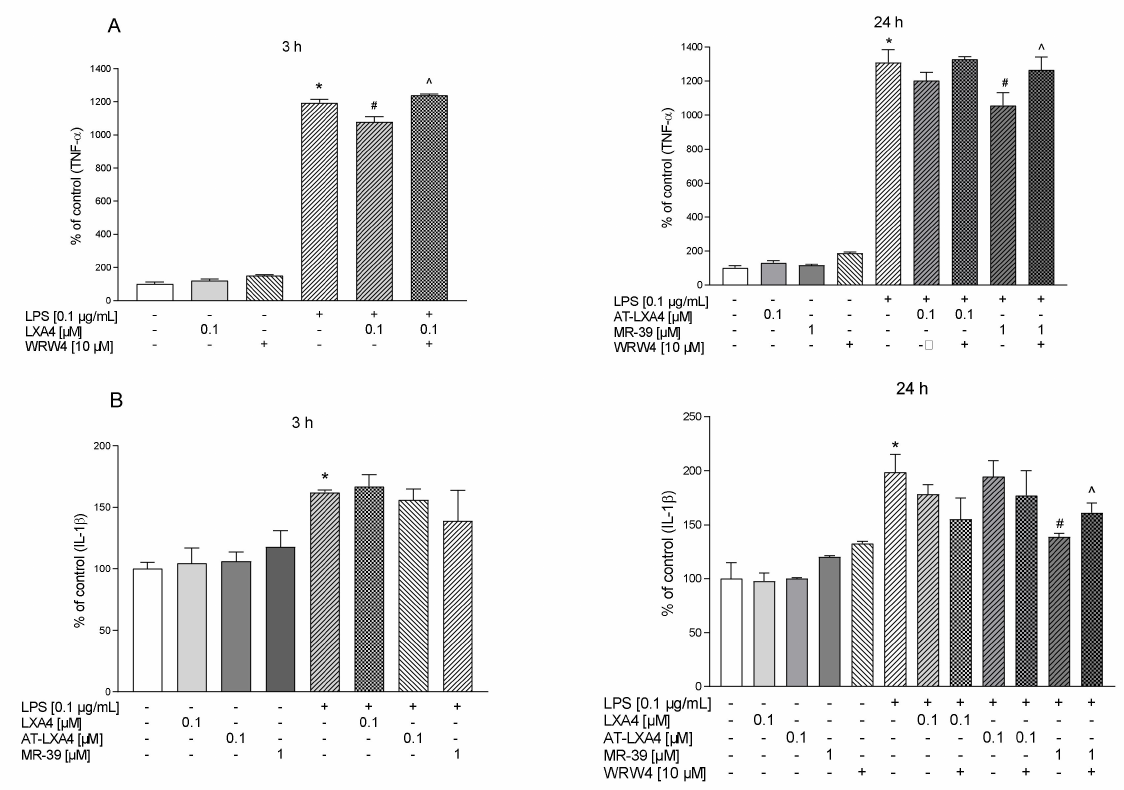
Figure 8. The impact of LXA4, AT-LXA4, and MR-39 on pro-inflammatory cytokines: TNF- α ( A ) and IL-1 β ( B ) production in rat microglial cultures. The cells were pretreated for 30 min with the FPR2 antagonist WRW4 (10 µ M). After that, LXA4 (0.1 µ M), AT-LXA4 (0.1 µ M), or MR-39 (1 µ M) was added for 1 h, and then the cells were stimulated for 3 h or 24 h with lipopolysaccharide (LPS; 0.1 µ g/mL). Control cultures were treated with the appropriate vehicle. The data are presented as the mean ± SEM percentage of the control (vehicle-treated cells) of independent experiments, n = 2–5 in each